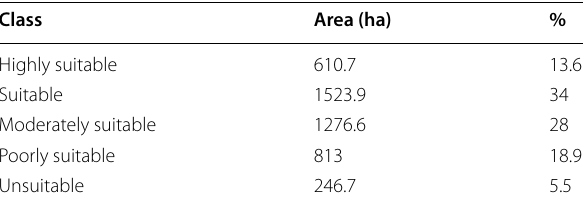
Table 6 Area cover of classified land suitability map for Sululta